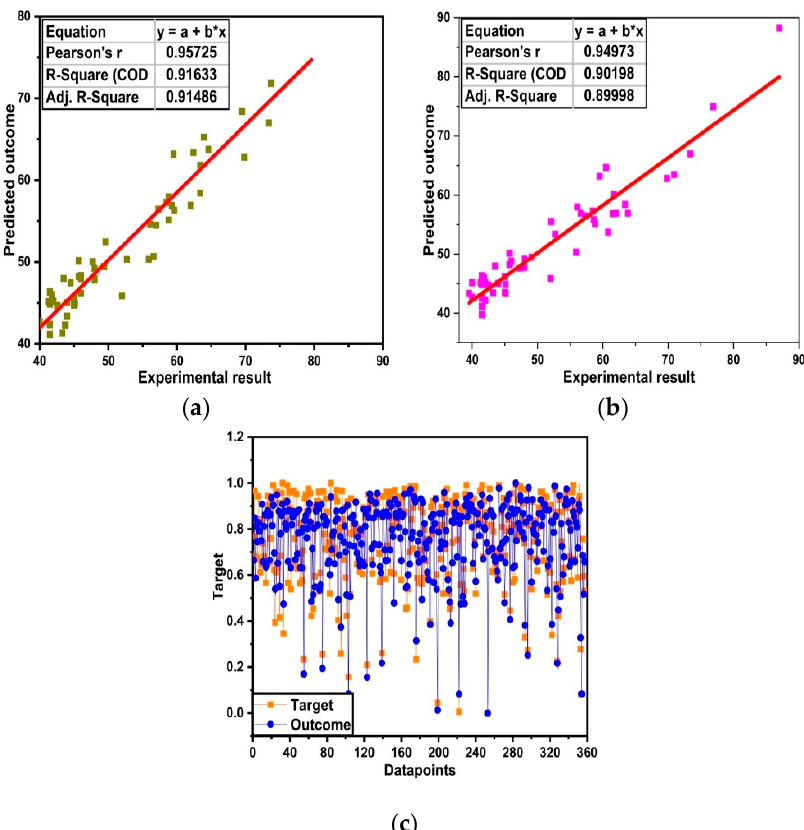
Figure 4. Model evaluation ( a ) Validation results of data based on GEP; ( b ) testing results of data; ( c ) normalized range of data.